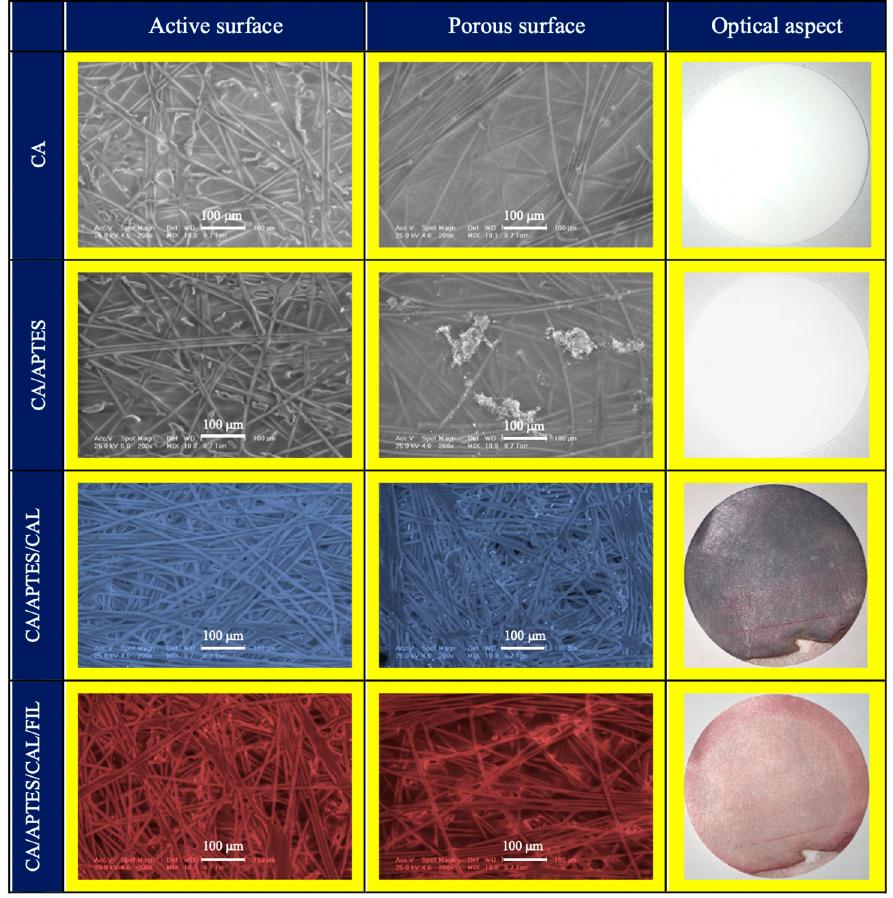
Figure2. ScanningElectronMicroscopyofsynthesizedmembranes(activesurfaceandporoussurface)and Figure 2. Scanning Electron Microscopy of synthesized membranes (active surface and optical aspect with evolution of color changing on the surface from dark blue for functionalized membrane porous surface) and optical aspect with evolution of color changing on the surface from with calmagite (CA / APTES / CAL) before and after filtration of Gd(III) to pink (CA / APTES / CAL / FIL) dark blue for functionalized membrane with calmagite (CA/APTES/CAL) before and after where FIL—filtration. APTES: Aminopropyl triethoxy silane, CA: Cellulose filtration of Gd(III) to pink (CA/APTES/CAL/FIL) where FIL—filtration. APTES: Aminopropyl triethoxy silane, CA: Cellulose acetate.